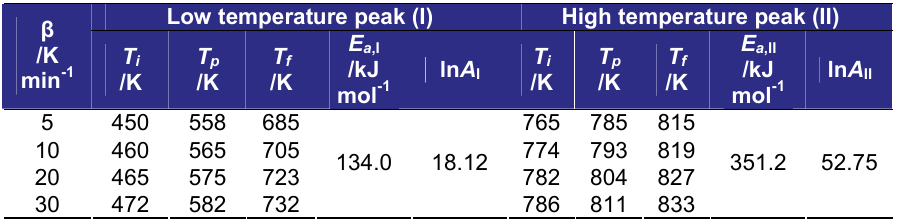
Table 2 – The influence of the heating rate ( β ) on the characteristic temperature values of the DSC curves; The values of the kinetic parameters (E a (I;II) and lnA (I;II) ) calculated by the Kissinger method are given in the same Table. Tabela 2 – Uticaj brzine zagrevanja ( β ) na karakteristi č ne temperaturske vrednosti